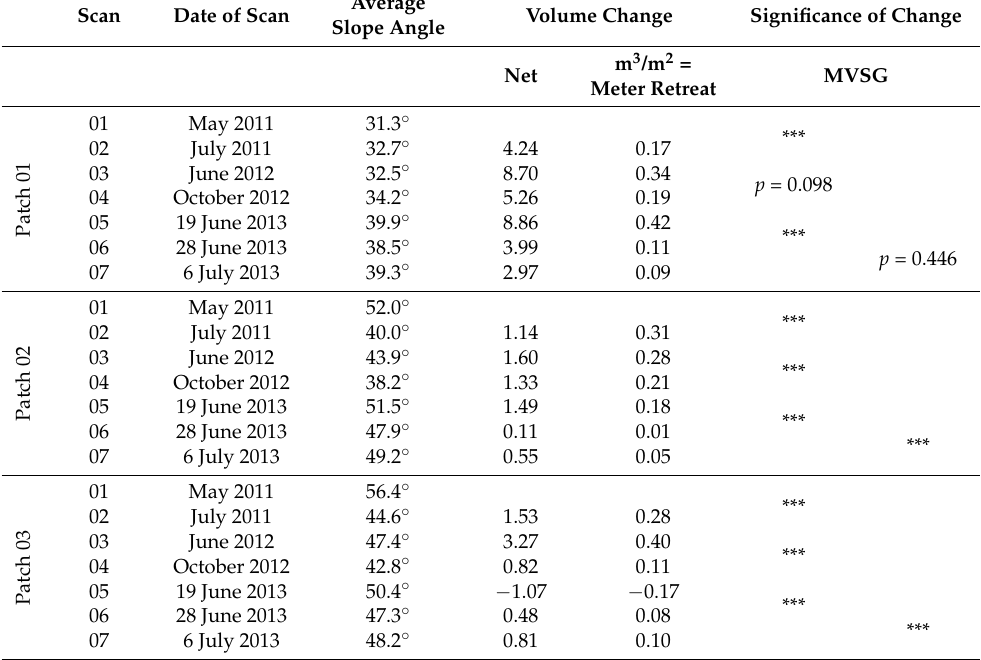
Table 3. Change of riverbank. MVSG, mean vertical slope gradient, and significance of change